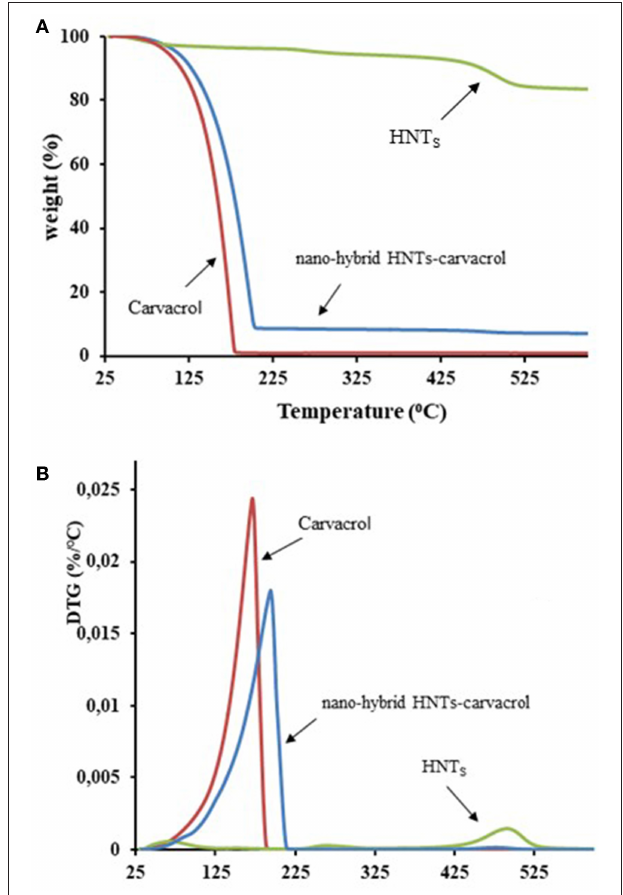
FIGURE 2 | Weight (%) (TG) (A) and derivative weight (%/ ◦ C) DTG (B) on the HNTs ( ), carvacrol ( ), and the nano-hybrid HNTs-carvacrol (